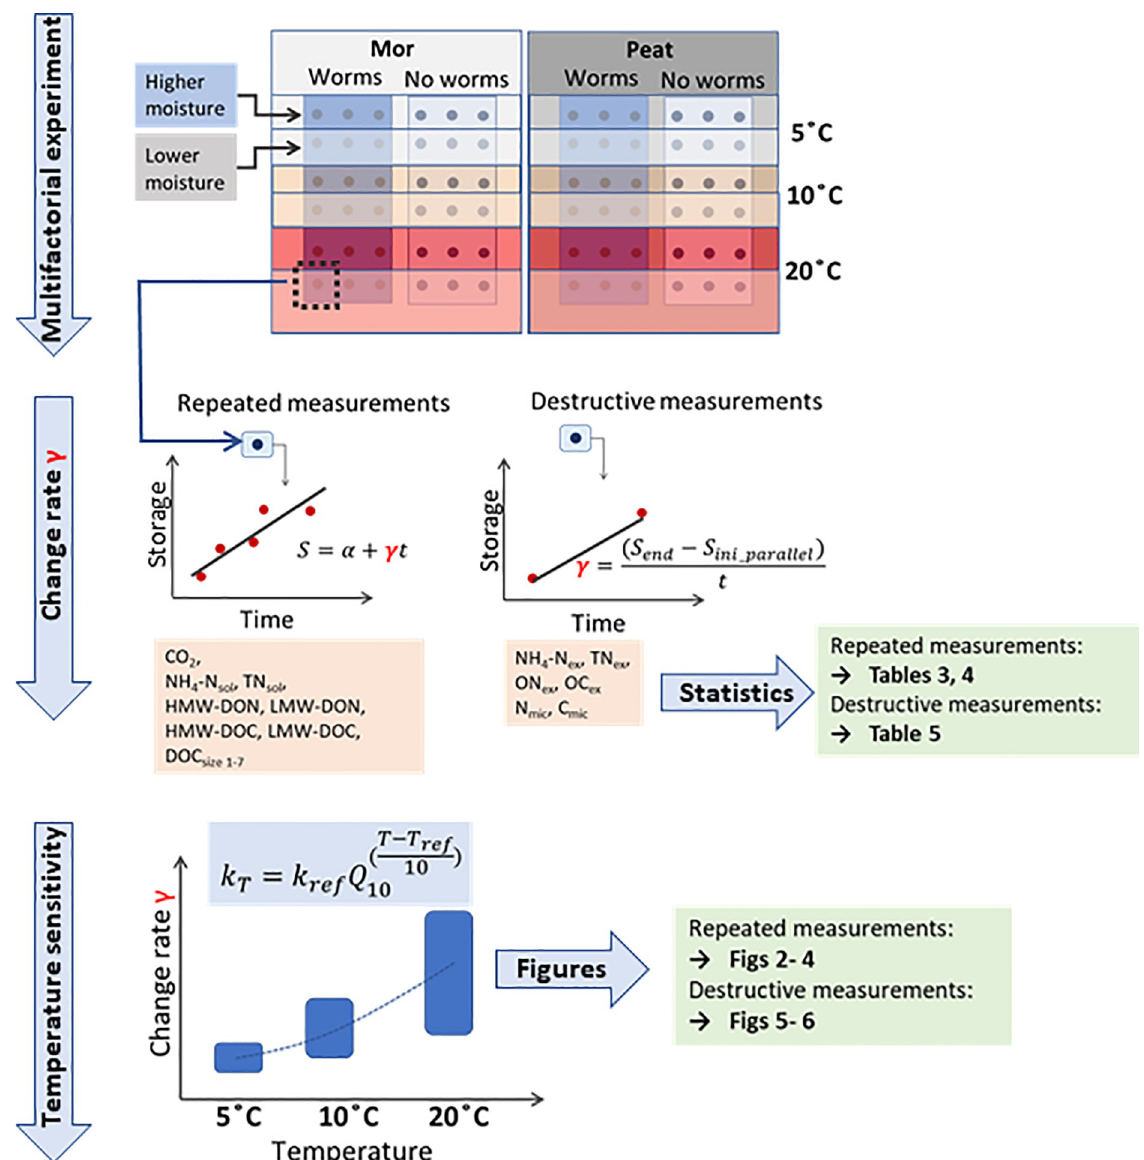
Fig 1. Study flowchart. In the multifactorial experiment we incubated two soil types in three different temperatures at two moisture levels and in the presence or absence of soil fauna. Three replicates were included in each treatment. The incubation time was 6 months. Repeated measurements were conducted during the experiment; CO 2 efflux was measured from the top of the sample and storage of soluble C and N were determined at different molecular sizes (NH 4 -N sol , TN sol , DOC, and DON in high-molecular-weight (HMW) and low-molecular-weight (LMW) fractions, and DOC in size classes 1–7). Rate of storage change ( γ , μ g g -1 day -1 ) was determined as the slope of the time-storage data of the repeated measurements. Analyses requiring destructive measurements (extractable and microbial C and N, denoted with subscripts “ex” and “mic”) were conducted after the experiment. The change in these storages was evaluated with respect to the initial storage of parallel samples. The change rate ( γ , μ g g -1 day -1 ) was determined by dividing the observed change with the duration of incubation. The effect of the experimental factors on the observed change rates were tested using linear mixed effect models (Tables 2–4). Temperature sensitivity analysis was conducted using the observed change rates ( γ ). Higher and lower moisture levels were combined (n = 6 for γ ) and Q 10 function was fit to the data. The observed temperature sensitivity patterns and the Q 10 values are presented in Figs